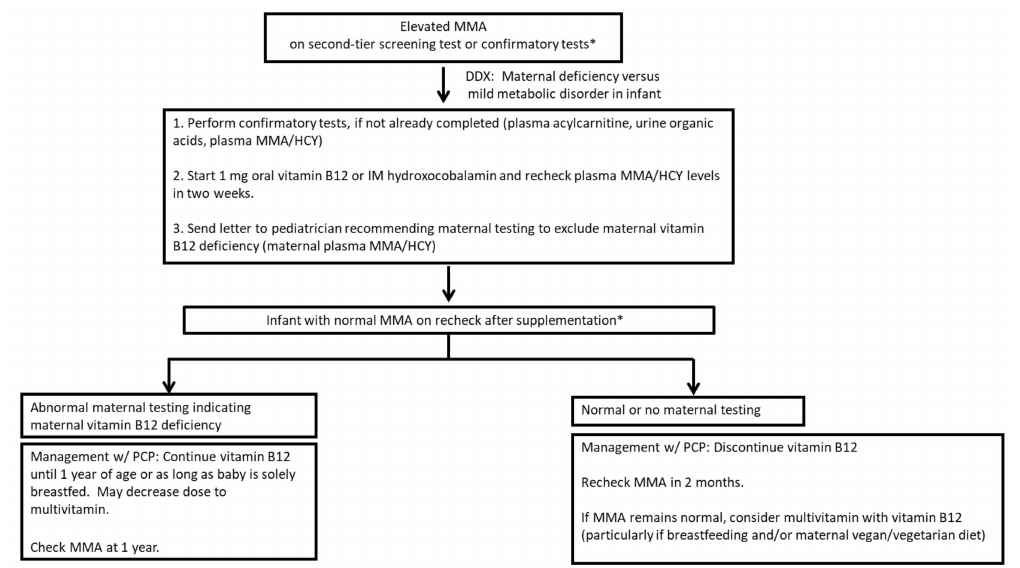
Figure 3. Diagnostic algorithm for evaluation of elevated methylmalonic acid (MMA) on second-tier or confirmatory testing. * Newborns with more abnormalities on confirmatory testing or